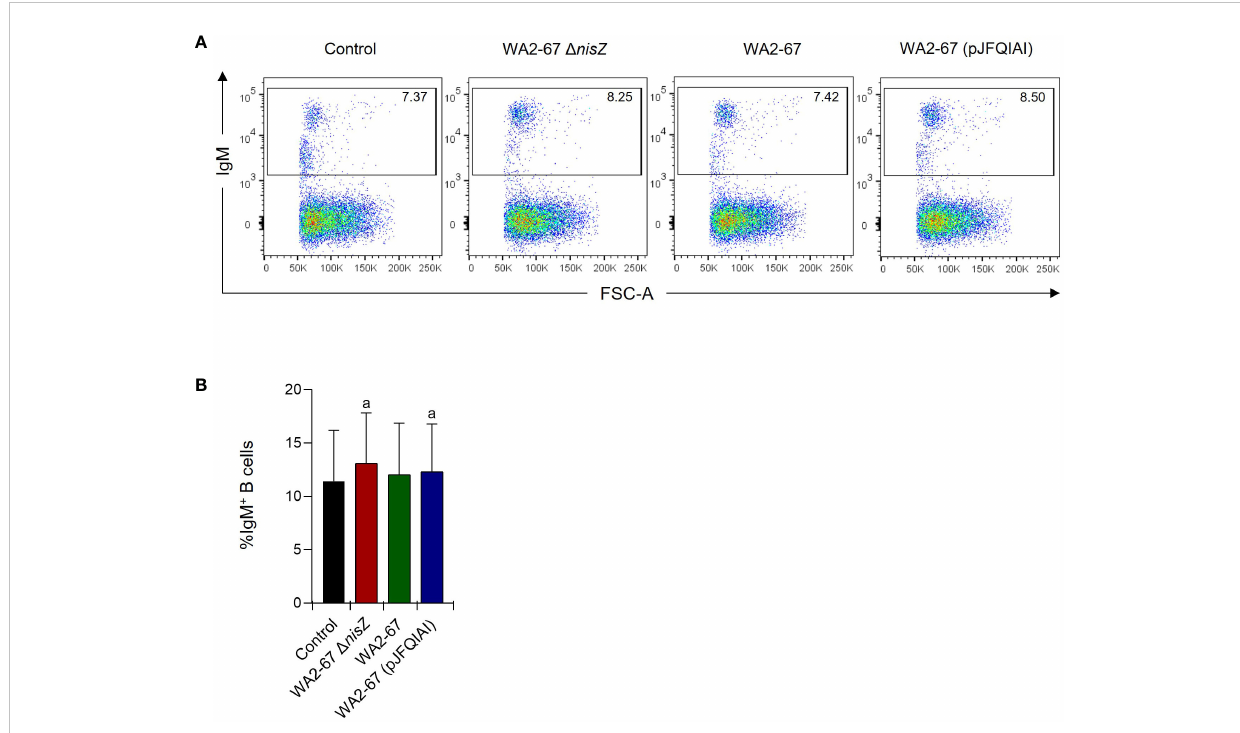
FIGURE 4 Effects of L. cremoris WA2-67 D nisZ , L. cremoris WA2-67, and L. cremoris WA2-67 (pJFQIAI) strains on the percentage of splenic IgM + B cells. The percentage of IgM + B cells was measured via fl ow cytometry using a speci fi c anti-IgM in spleen leukocyte cultures treated with 1 x 10 6 cfu/ml of each bacterial strain for 48 h. Controls not treated with bacteria were also included. Representative dot plots (A) are included along with a graph (B) showing the percentage of live IgM + B cells in the lymphocyte gate (mean + SD; n=5). The letter (a) represents transcription levels signi fi cantly different than those observed in cells not exposed to bacterial strains